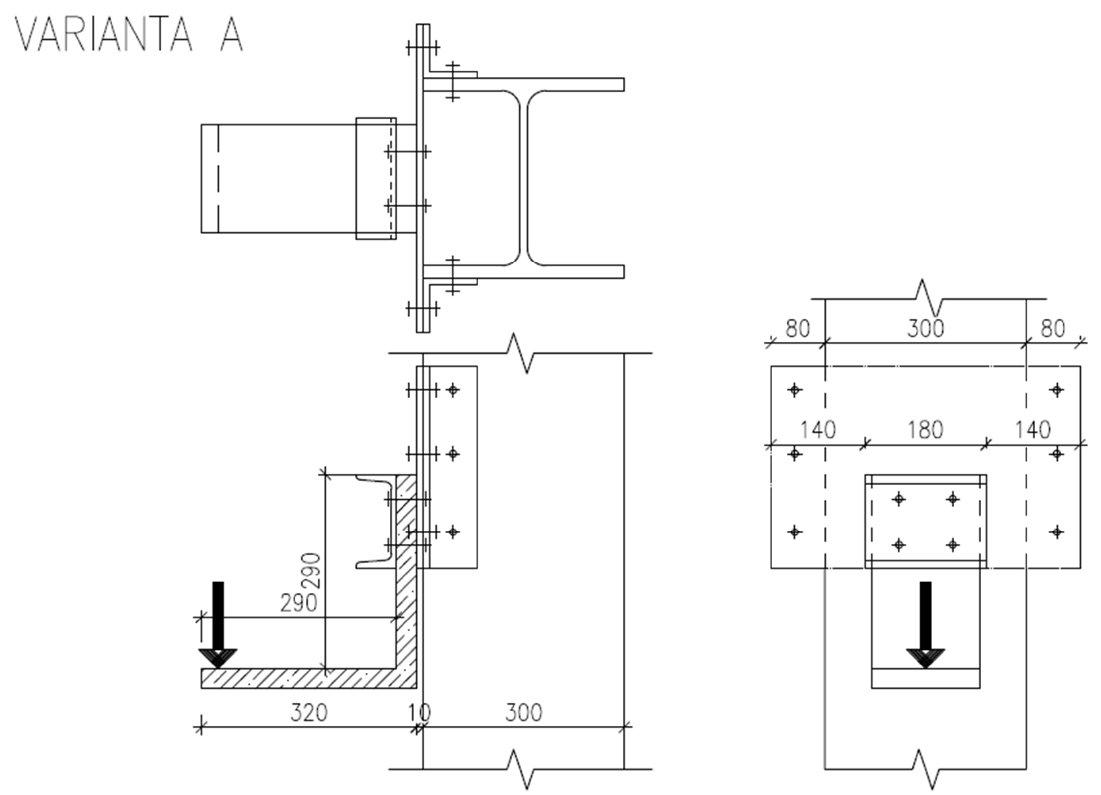
Figure 9. Design of the load-bearing destructive test for verification of the numerical model. The arrows mark the position of the loading force.